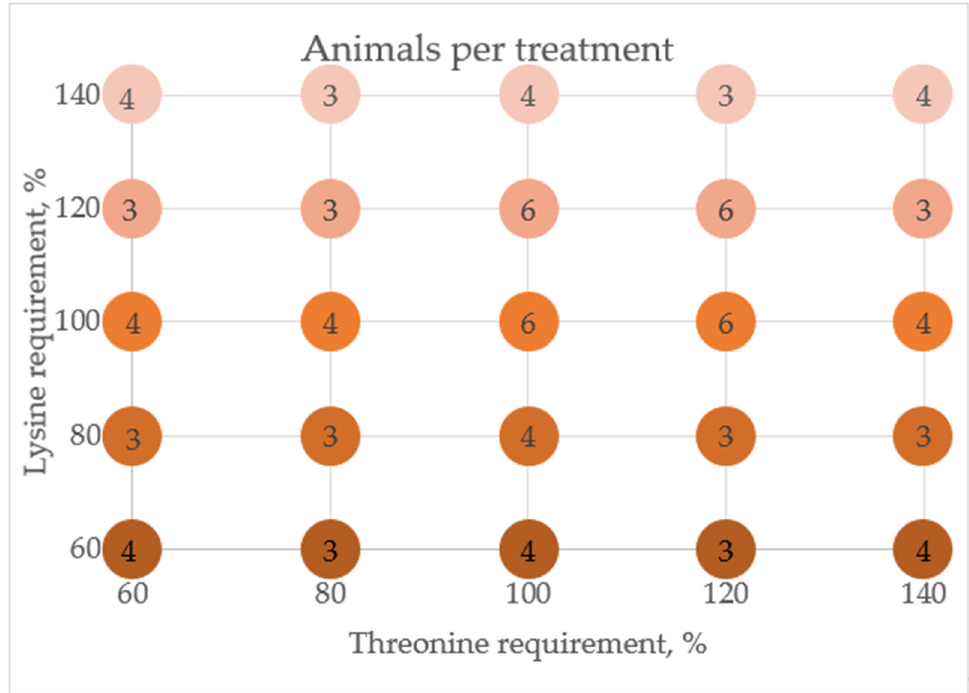
Figure 1. Complete unbalanced factorial design, based on a central composite design, circles contain the number of pigs assigned to each treatment combination of between 60% and 140% threonine and lysine estimated dietary requirements.